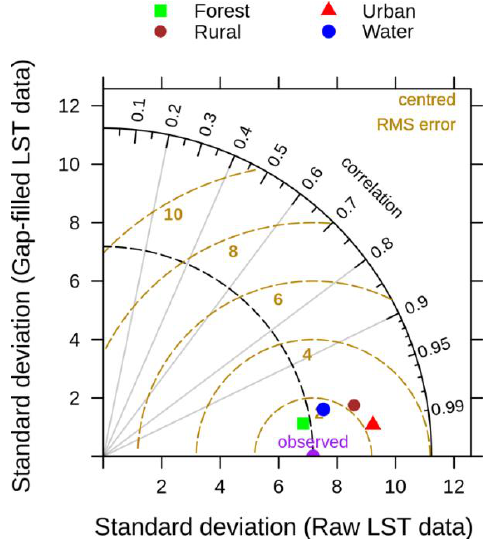
Figure 7. Statistical summary of the matching performance obtained using the DINEOF gap-filling method. The gap-filled data set was compared to observations using a validation subset containing 50% of the selected LST images, and 1000 randomly selected pixels assigned as NA for each image.